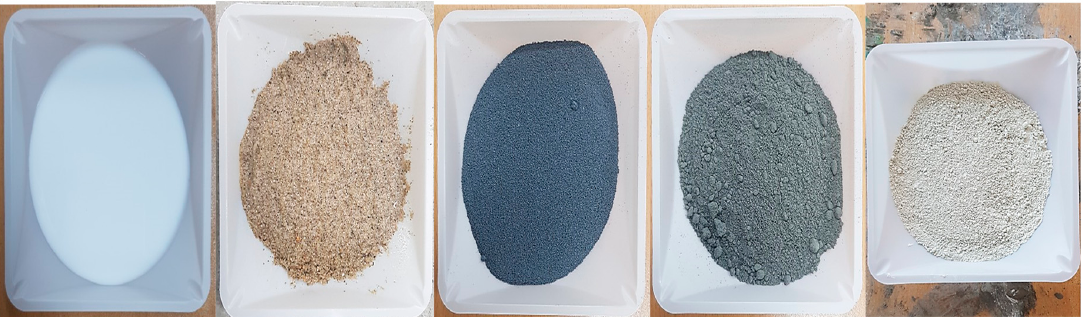
Figure 1. Water repellent coating and impregnated powder (Water repellent, Sand–Co Silica–Co, Fly ash (FA)–Co, water-repellent impregnated natural zeolite (ZWR).